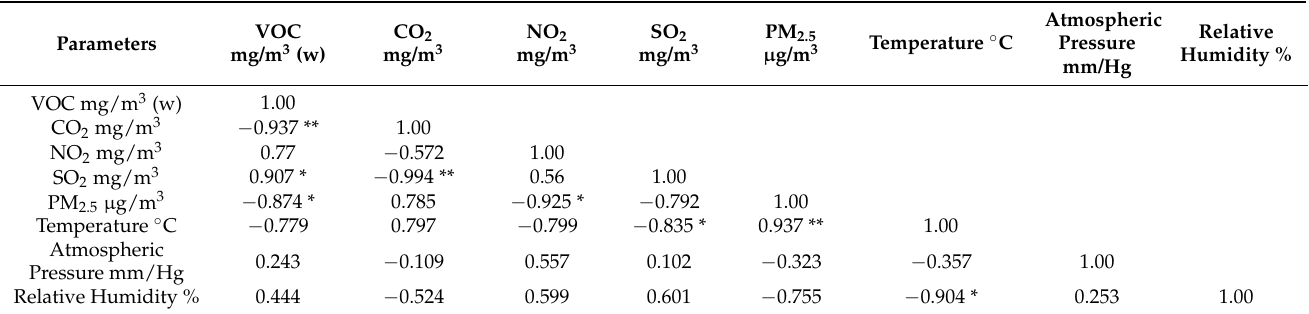
Table 2. Relationship between air quality and meteorological parameters across the study area (wet season). Parameters